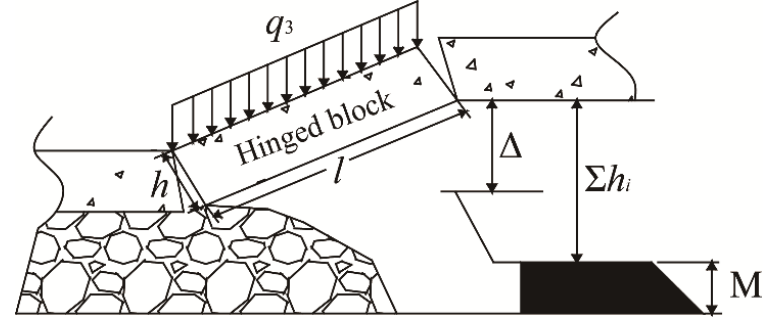
Figure 9. Hinged structure of KS2.